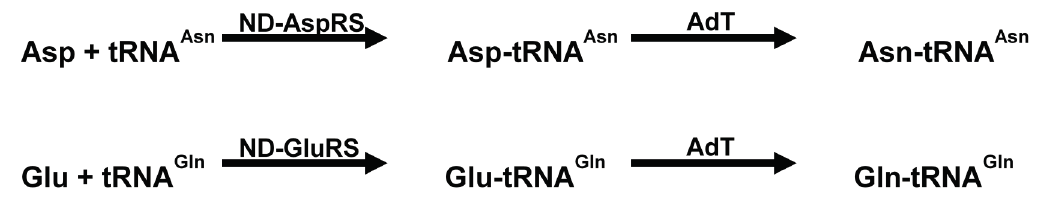
Scheme 1. Reaction catalyzed by non-discriminating AspRS/GluRS and